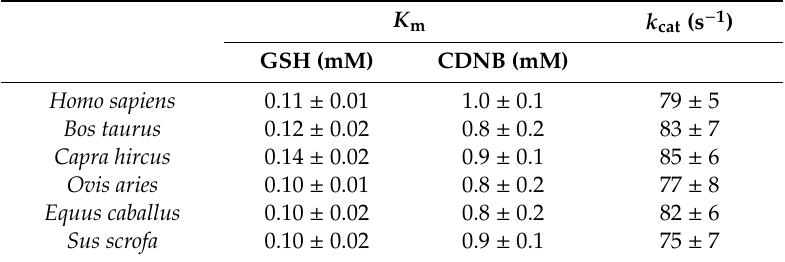
Table 3. A comparison of the kinetics parameters of mammalian e-GSTs (modified from Reference [194]).